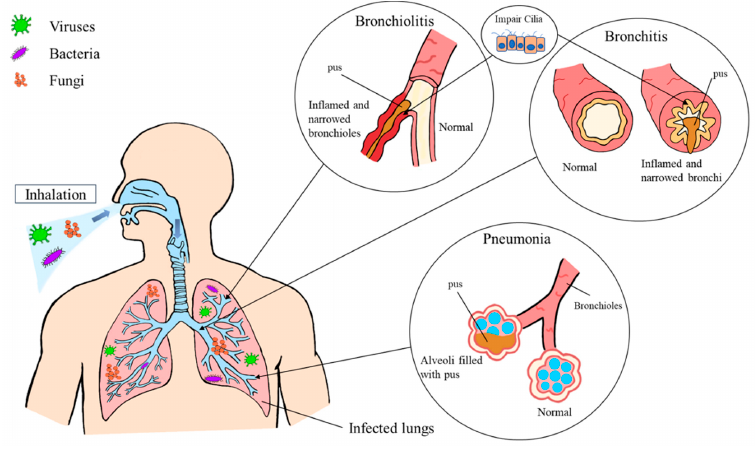
Figure 1. Representation of different types of lung infections.